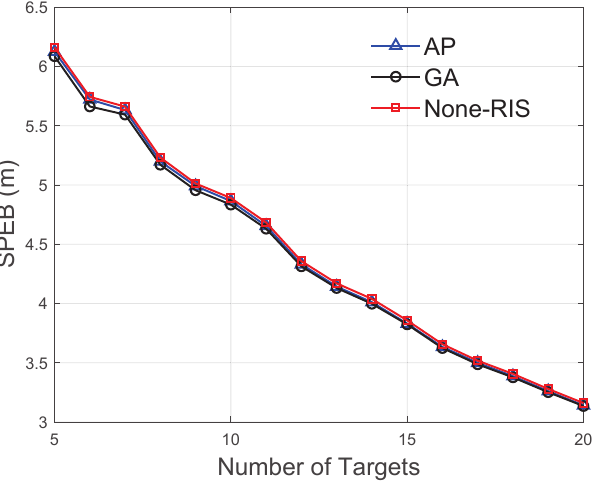
Figure 4. SPEB with different number of